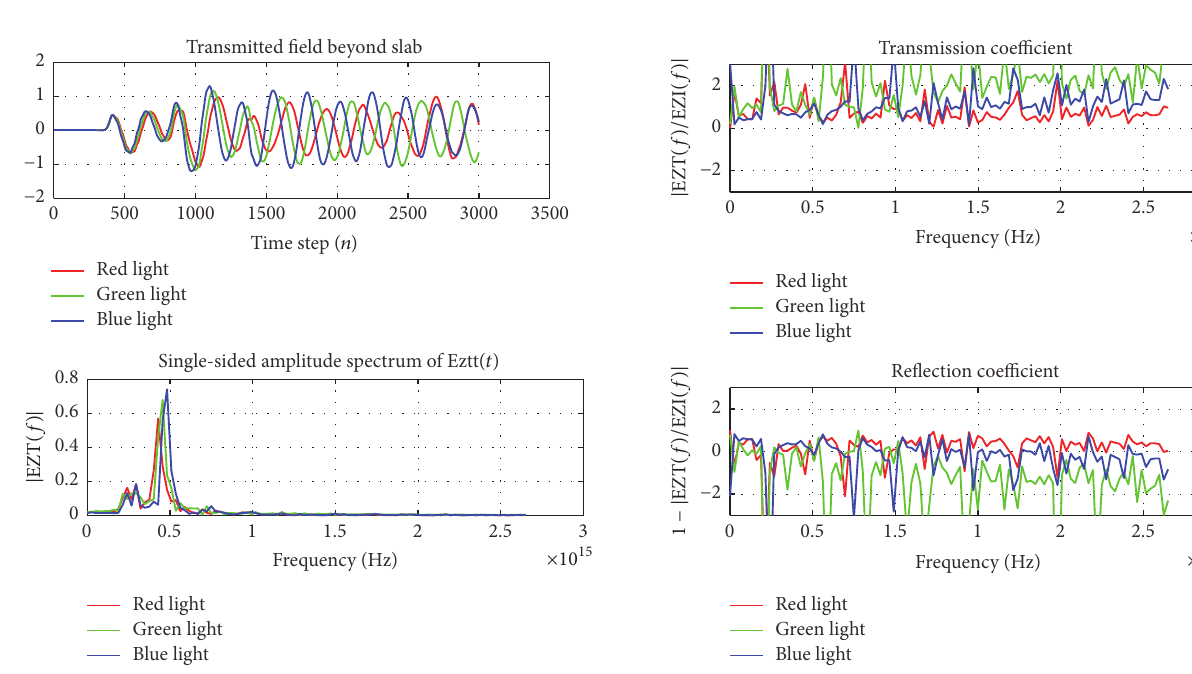
Figure 17: Transmission and reflection coefficient versus frequency for red, green, and blue light corresponding to conditions in Table 5.